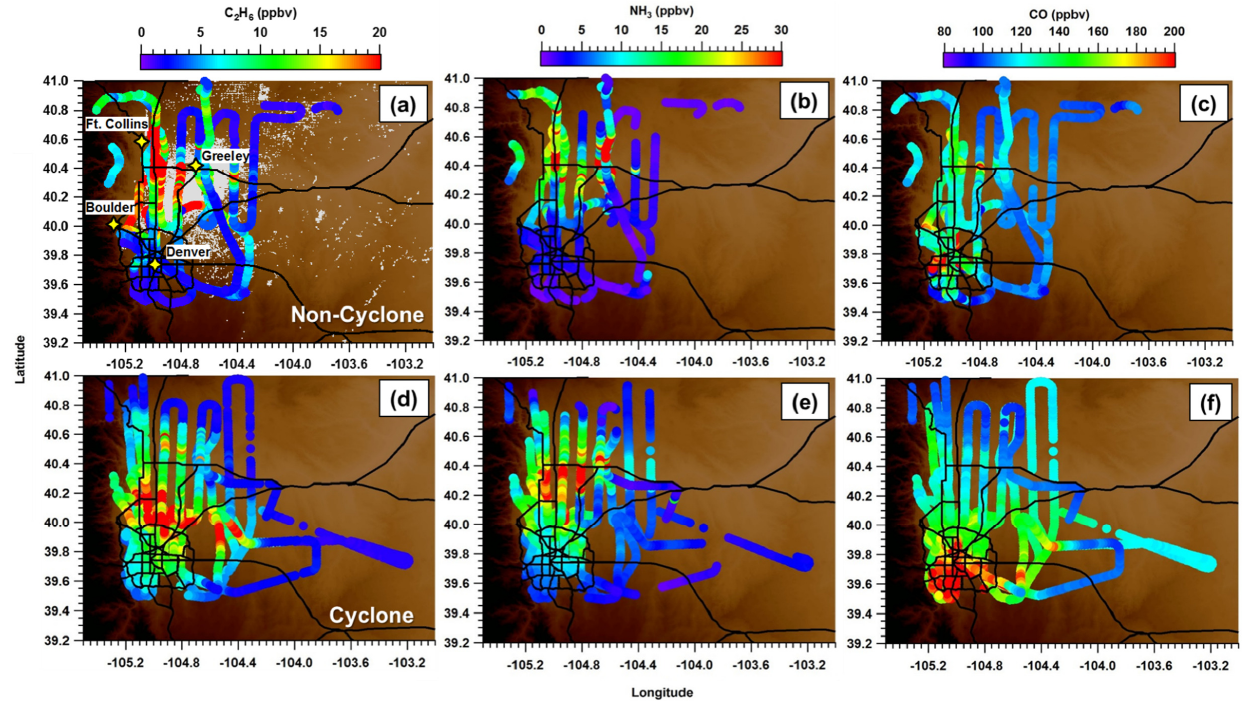
Figure 4. Spatial distribution maps along the C130 flight track of ethane (C 2 H 6 ), ammonia (NH 3 ), and carbon monoxide (CO) in the Colorado Front Range during non-cyclone (a–c) and cyclone episodes (d–f) . Major highways are shown with black lines, and grey markers in (a) represent the location of active oil and gas wells in the region with data available from the Colorado Oil and Gas Conservative